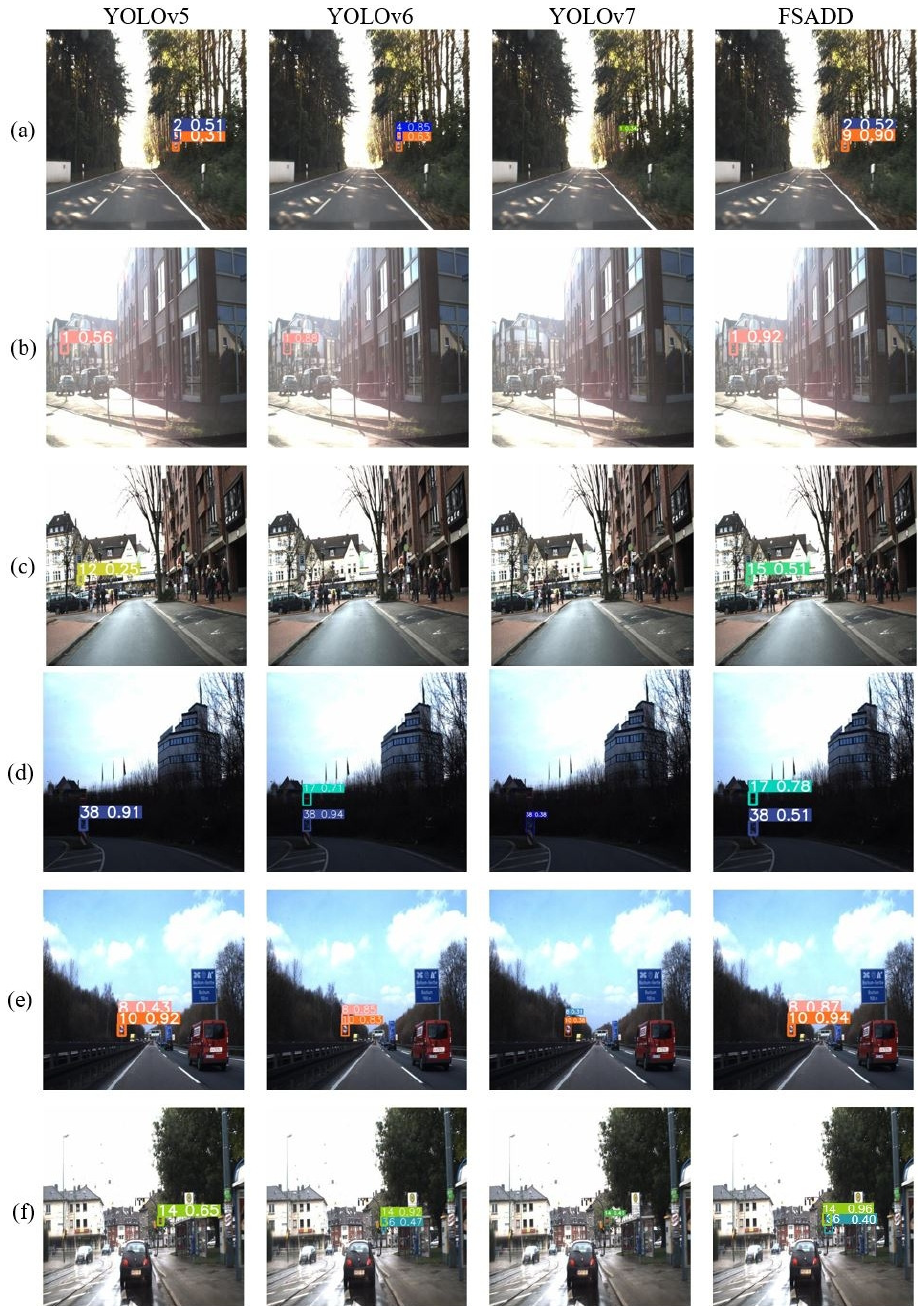
Figure 9. Traffic sign detection performance comparisons (YOLOv5, YOLOv6, YOLOv7, and FSADD)—Part 1: ( a ) ground truth—17 and 38, ( b ) ground truth—1, ( c ) ground truth—15, ( d ) ground truth—17 and 38, ( e ) ground truth—8 and 10, and ( f ) ground truth—14 and